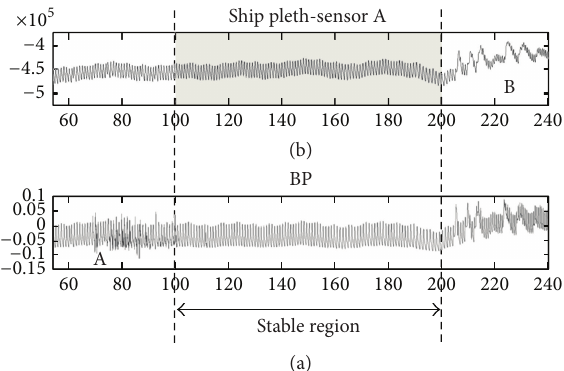
Figure2:Selectionofastableregion((b)fingerplethand(a)arterial